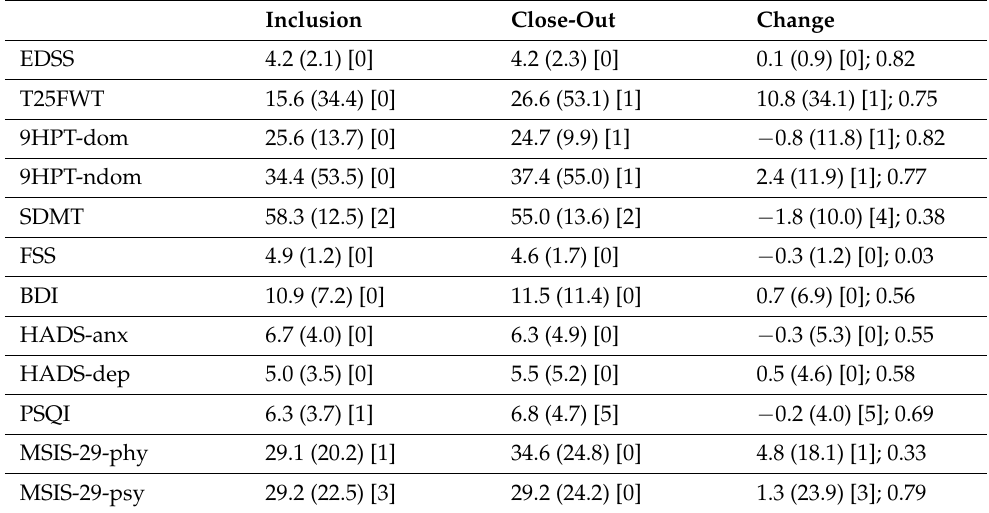
Table 2. Functional outcomes in patients randomized to the intervention group who completed the study ( N = 26) *.